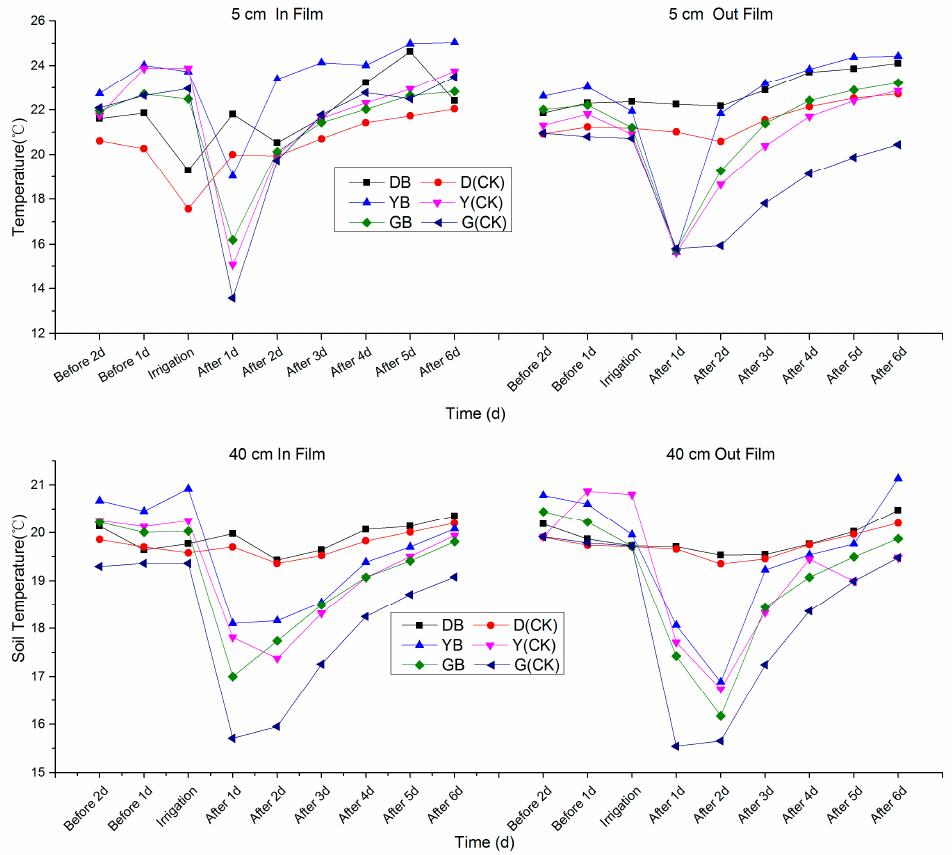
Figure 9. Effects of irrigation on soil temperature at different treatments and depths in 2016.